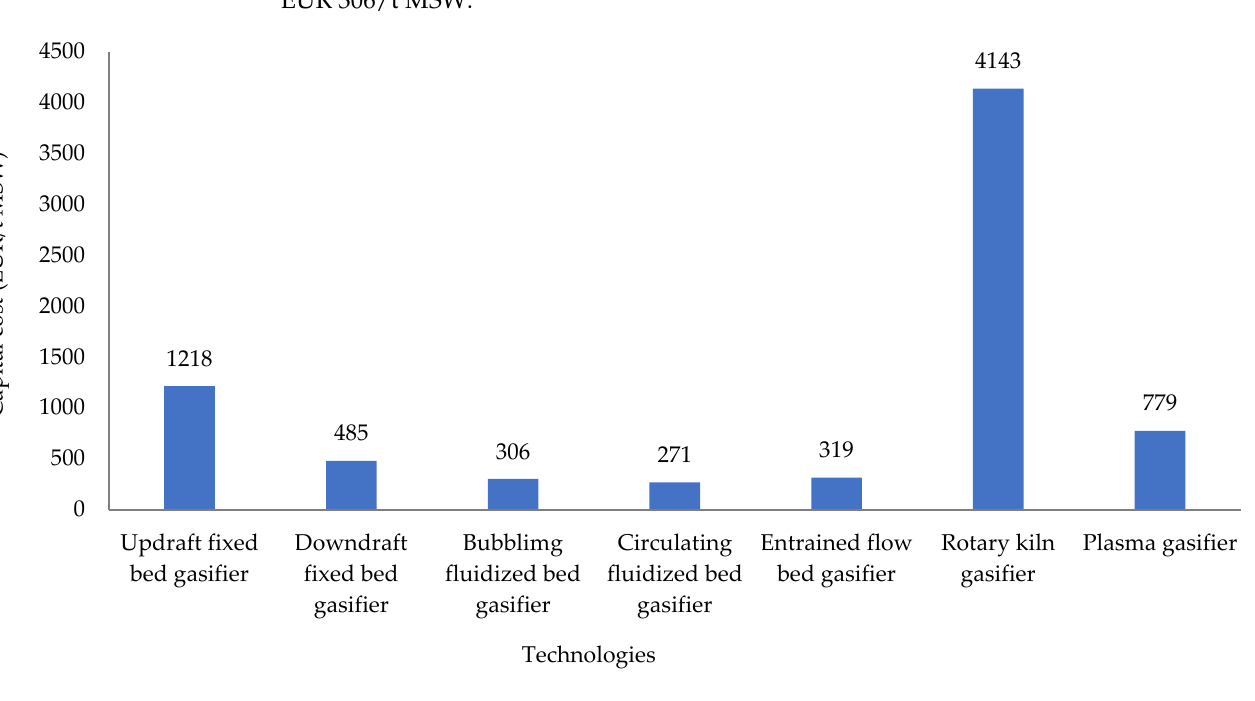
Figure 6. Comparison of the capital cost of different gasification technologies (adapted from [43]). Original data presented in USD/t and converted to EUR/t (EUR 1 = USD 0.99860 according to Banco de Portugal, 2022 [47]) .